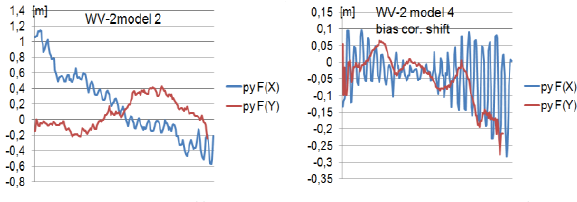
Figure 2. Systematic y-parallaxes of WorldView-2 height models 2 and 4 based on different bias correction [m]